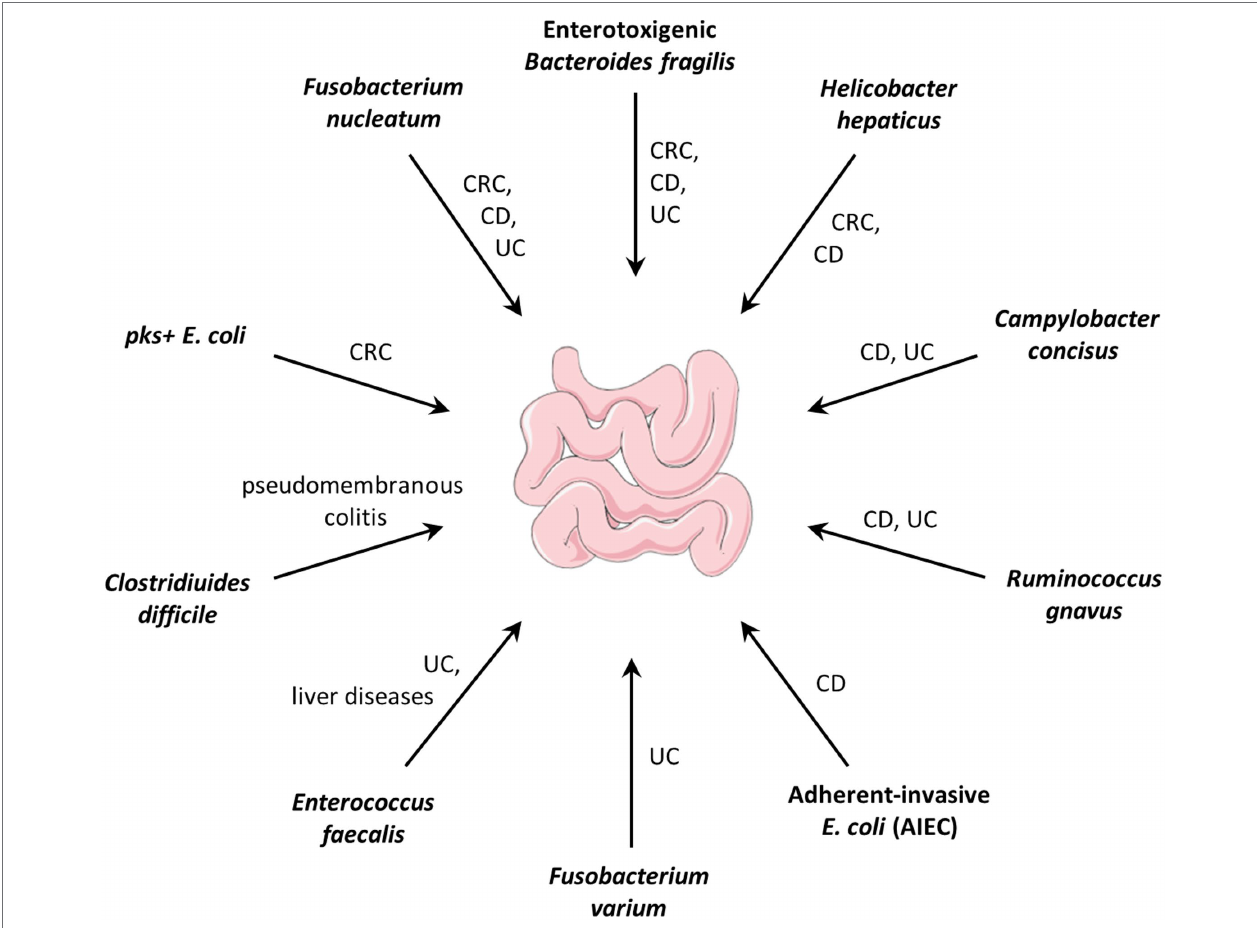
FIGURE 1 | Gut pathobionts and their related diseases. CRC: colorectal cancer; CD: Crohn’s disease; UC: ulcerative